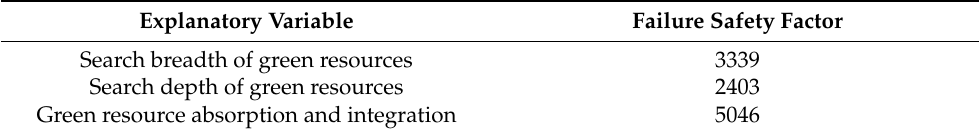
Table 3. Publication Bias Test